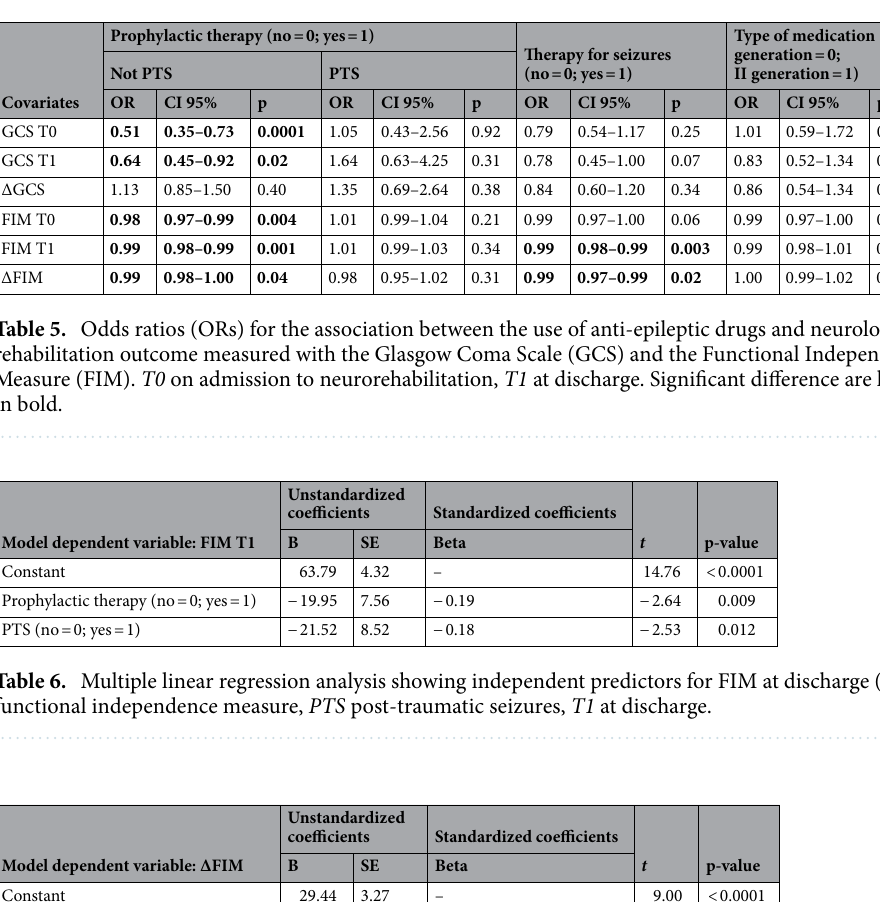
Model dependent variable: